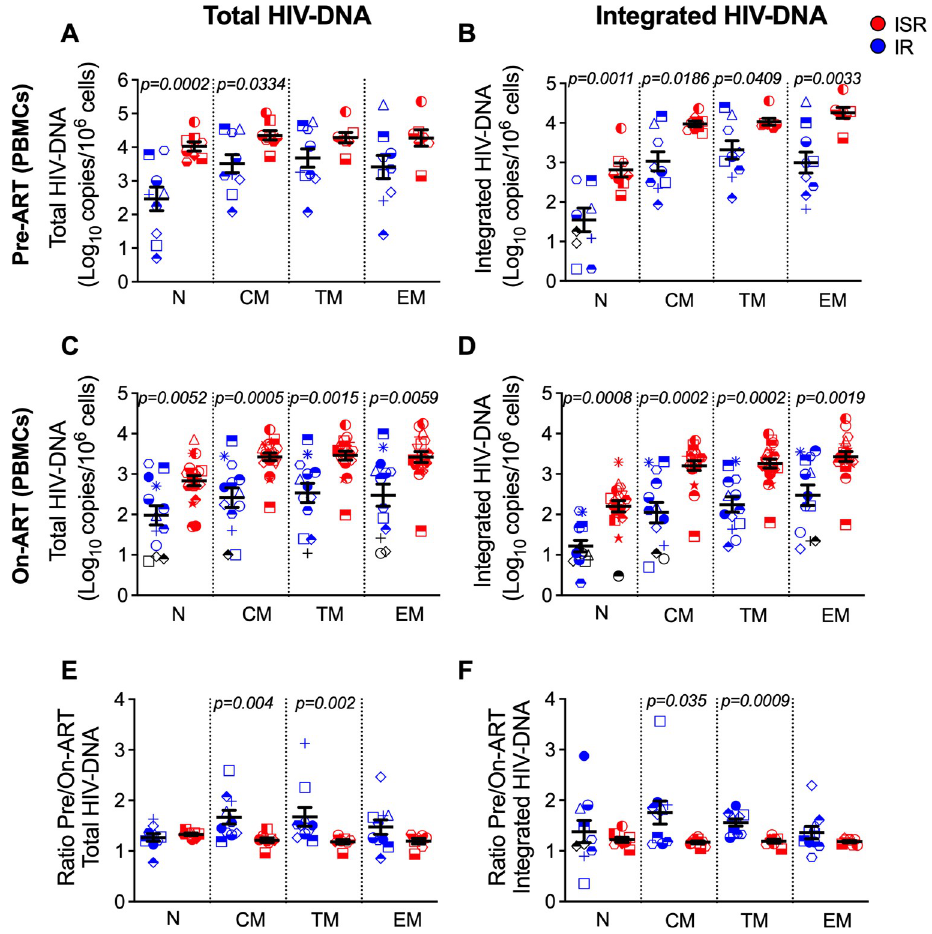
Fig 2. HIV-DNA reservoir levels are higher in ISR at baseline and during follow-up. (A) Total HIV-DNA cellular infection in peripheral blood CD4 T-cell subsets before ART initiation among immunologic responder (IR; blue, n = 10) and suboptimal responder (ISR; red, n = 8). (B) Integrated HIV-DNA cellular infection in peripheral blood CD4 T-cell subsets before ART initiation (IR, n = 10; ISR, n = 8). (C) Total HIV-DNA cellular infection in peripheral blood CD4 T-cell subsets after ART initiation (IR, n = 13; ISR, n = 19). (D) Integrated HIV-DNA cellular infection in peripheral blood CD4 T-cell subsets after ART initiation (IR, n = 13; ISR, n = 19). (E) Ratio pre-ART/On-ART ((Log 10 copies pre-ART/10 6 cells)/ (Log 10 copies on-ART/10 6 cells)) of total HIV-DNA, and (F) integrated HIV-DNA on blood CD4 T-cell subsets in immunologic responder (IR; blue, n = 10) and suboptimal responder (ISR; red, n = 8). CD4 T-cell subsets included na ï ve (N), central memory (CM), transitional memory (TM), and effector memory (EM) cells. Samples for which no target was detected are plotted at the limit of detection of the assay (calculated from cell input) and are represented as black symbols, and samples for which less than 3,000 cells were assayed were excluded from the analysis. Data show raw mean values and SEM. Repeated-measures analyses were performed with a means model (SAS MIXED Procedure, version 9.4) to generate statistical outcomes between IR and